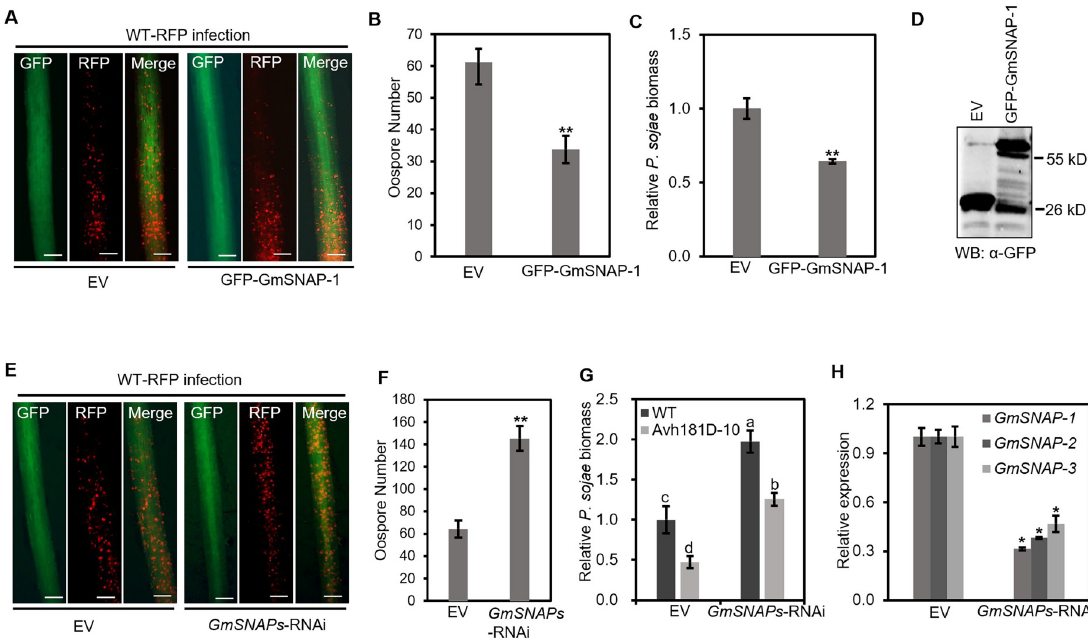
Fig 6. GmSNAPs contribute to soybean defense against P . sojae . (A) Infection assays using P sojae on the soybean hairy roots expressing N-terminal GFP-tagged GmSNAP-1. The transgenic soybean hairy roots were inoculated with RFP labeled P . sojae WT (P6497) and investigated by fluorescence microscopy. Scale bars, 0.2 mm. (B) Quantification of P . sojae oospore production at 48 h post inoculation. Data are the mean ± SEM of five replicates. Asterisks at the top of the bars indicate significant differences ( P < 0.01; one-way ANOVA). (C) The relative biomass of P . sojae was determined by qPCR using genomic DNA. Data are the mean ± SEM of five replicates. Asterisks at the top of the bars indicate significant differences ( P < 0.01; one-way ANOVA). (D) Expression of EV (GFP) and GFP-GmSNAP-1 was detected by western blot analysis using anti-GFP antibody. (E) Infection of RFP-labeled P . sojae in the transgenic GmSNAPs-silenced hairy roots. (F) Quantification of oospore production at 48 h after inoculation. Data are the mean ± SEM of five replicates. Asterisks at the top of the bars indicate significant differences ( P < 0.01; one-way ANOVA). (G) Infection of the PsAvh181 knockout mutant Avh181D-10 in the GmSNAPs silenced hairy roots. Relative P . sojae biomass was determined by genomic DNA qPCR. Data are the mean ± SEM of five replicates. Different letters at the top of bars indicate significant differences ( P < 0.01; one-way ANOVA). (H) Relative expression levels of GmSNAP-1 , GmSNAP-2 and GmSNAP-3 . Data are the mean ± SEM of five replicates. Asterisks at the top of the bars indicate significant differences ( P < 0.05 one-way ANOVA).